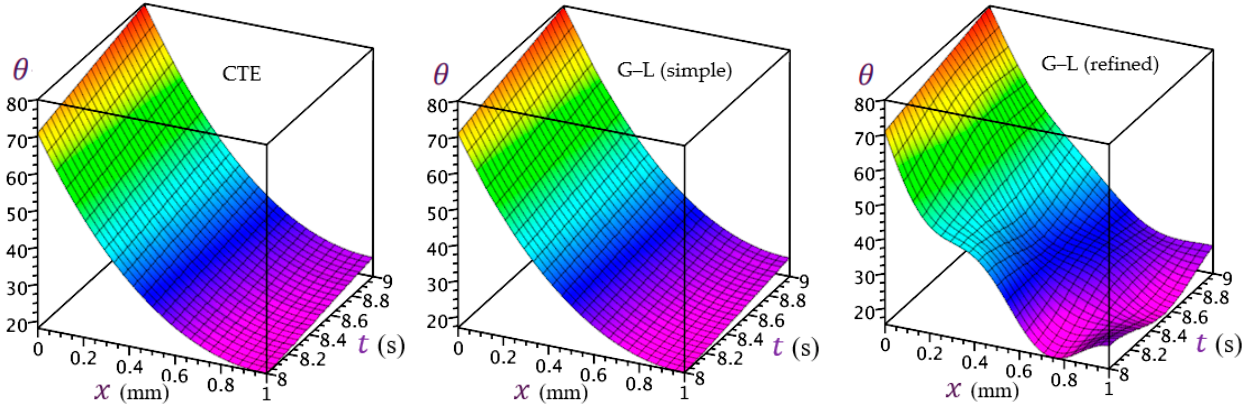
Figure 19. Three-dimensional plots of the temperature 𝜃 along the 𝑥 -axis of the skin tissue due to different theories of thermoelasticity.